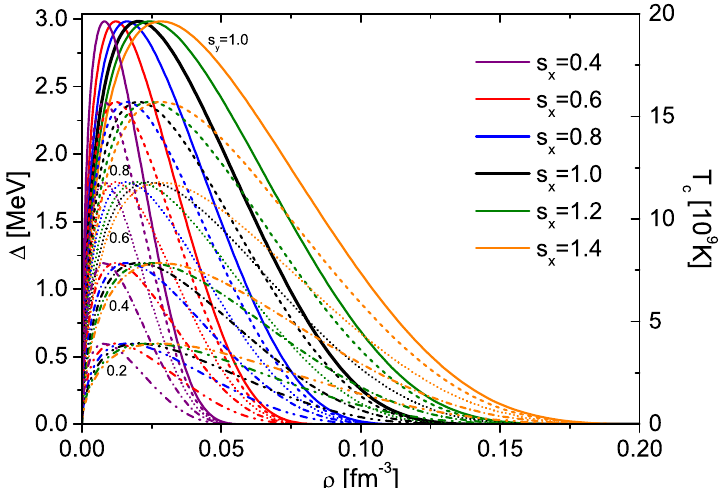
Figure 2. V18 BCS 1S0 pairing gap as a function of particle number density with different scale factors s x and s y applied, see Equation